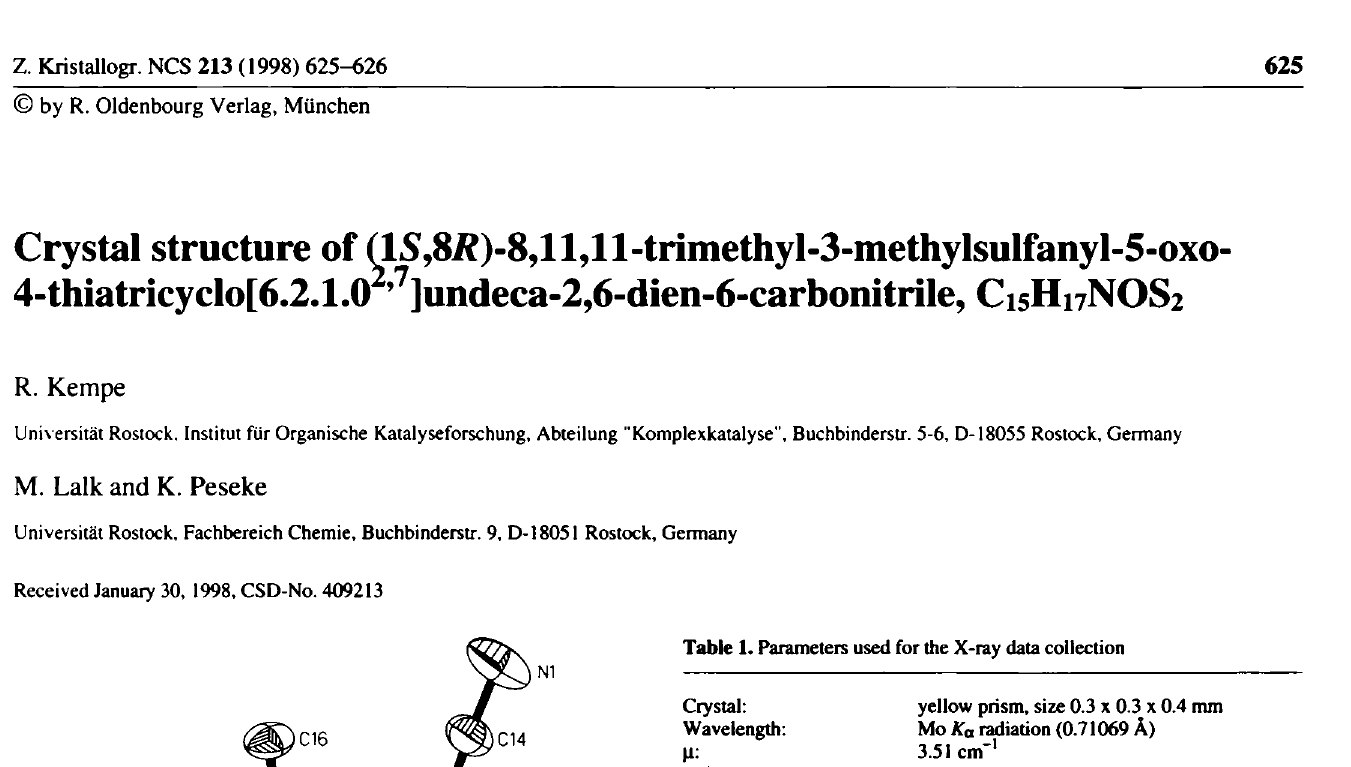
Table 2. Final atomic coordinates and displacement parameters (in